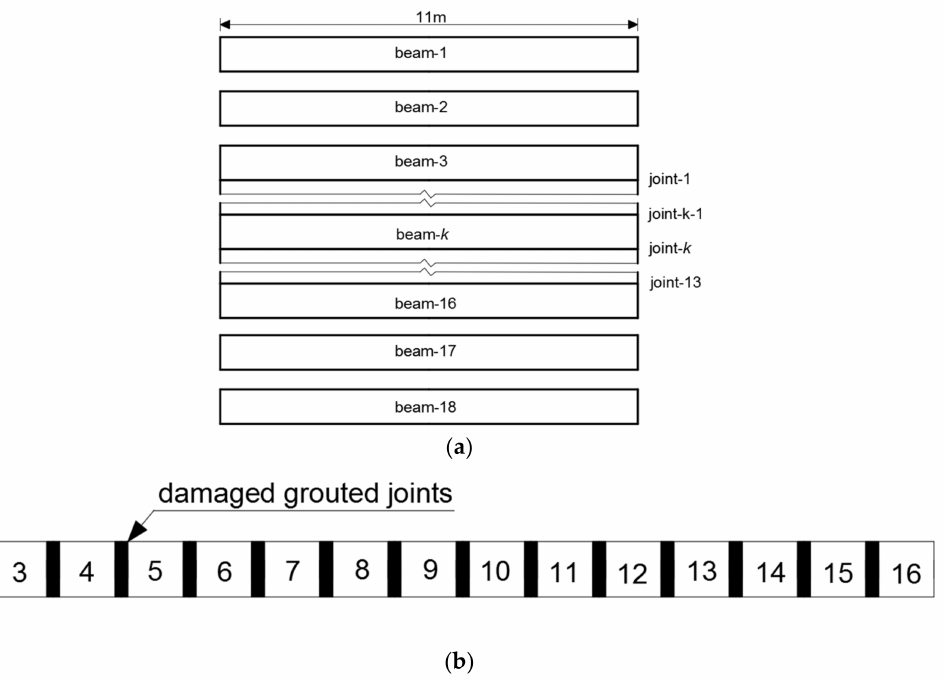
Figure 5. ( a ) Arrangement of numbers of beams and joints of Yunhe Bridge. ( b ) Location of damaged joints of Yunhe